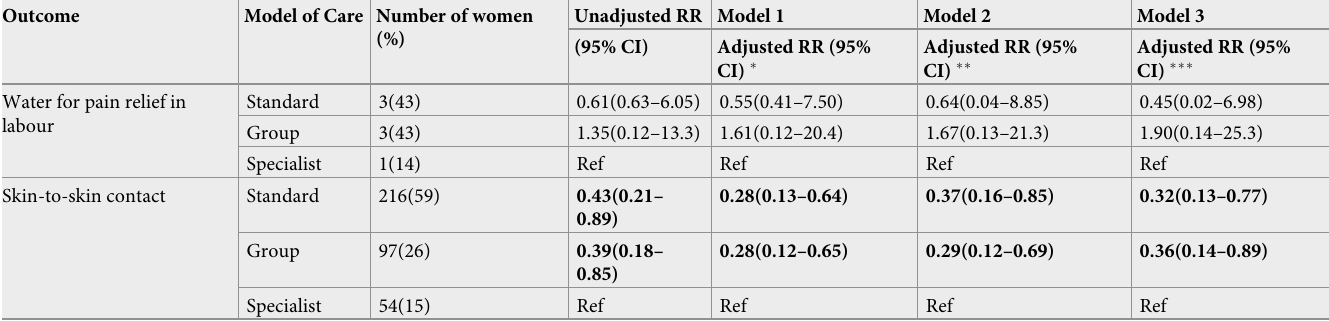
� Model 1: Adjusted for demographics ethnicity, age, parity, IMD score, any social and medical risk factors at booking and onset of labour. �� Model 2: Model 1 + Adjustment for place of antenatal care (community or hospital). ��� Model 3: Model 2 + Adjustment for service provider attended (A or